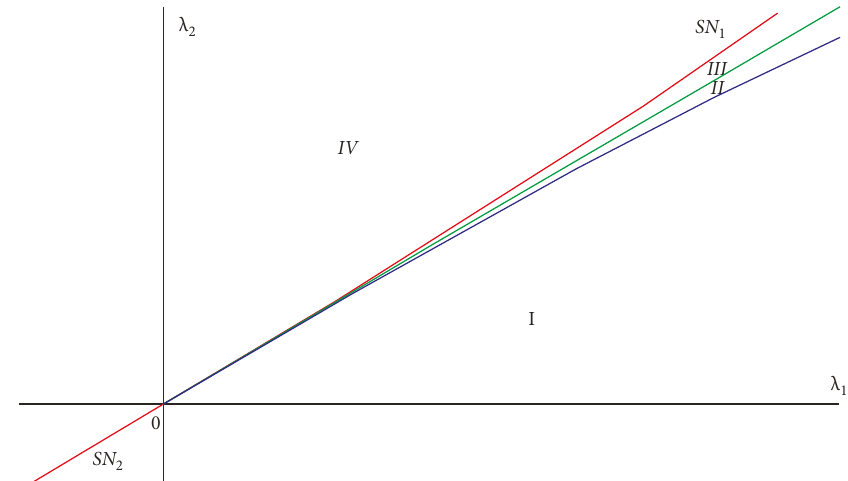
Figure 14: Saddle-node (in red), hopf (in green) and homoclinic (in blue) bifurcation curves in the case ( C